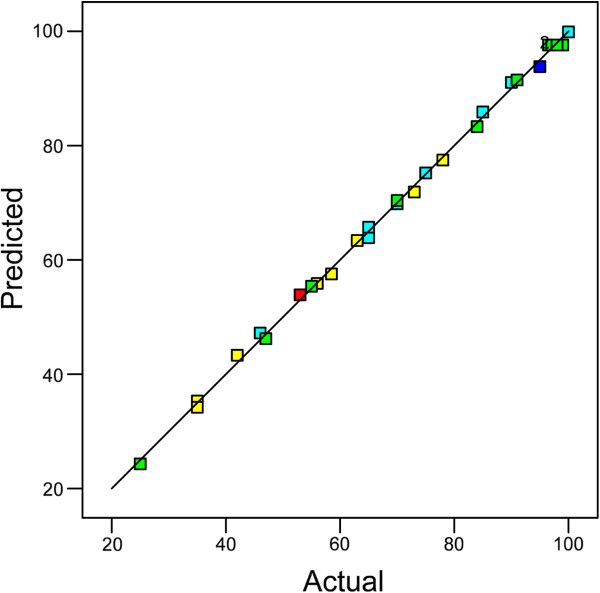
The scatter plot of predicted values versus actual values of p-cresol photodegradation. The coefficient of R-squared (R2) is 0.9987.